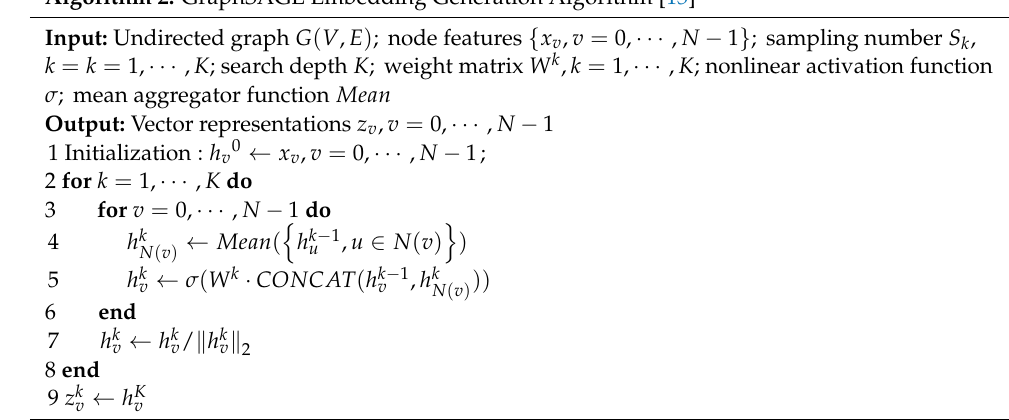
Algorithm 2: GraphSAGE Embedding Generation Algorithm